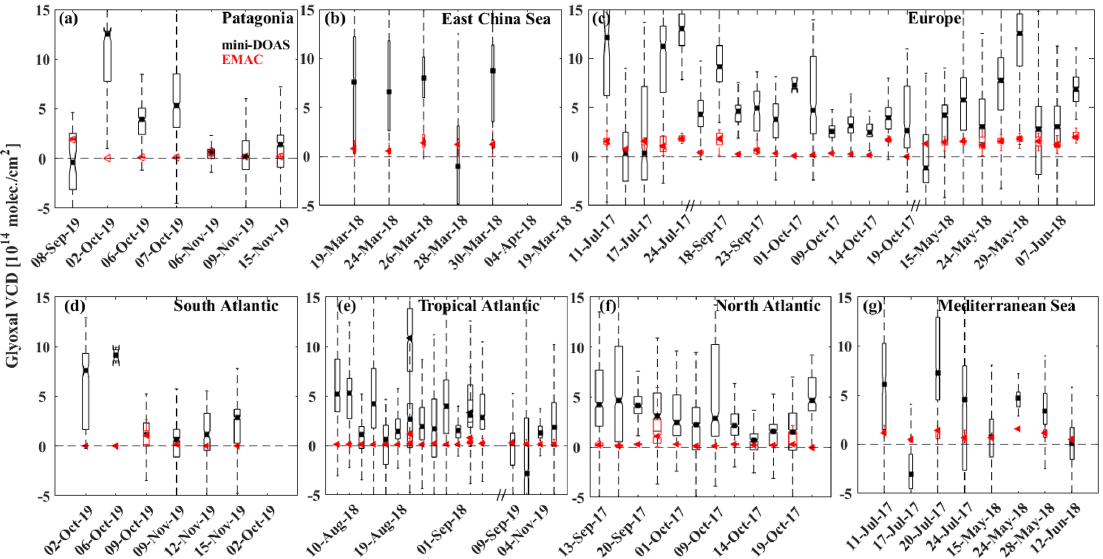
Figure 12. Comparison of measured airborne (black) and simulated (red) glyoxal VCDs in the different regions and for all flight altitudes of the measured